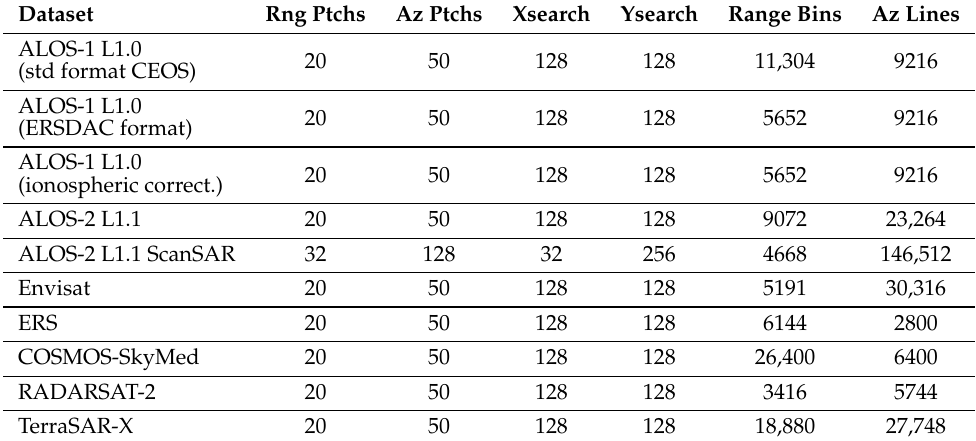
Table 1. Datasets from the GMTSAR repository used for testing. For each dataset: the number of patches along range direction and along azimuth; search dimensions in elements on x and y direction, per patch; the number of bins in range direction and the number of lines along azimuth, in the SLC files to